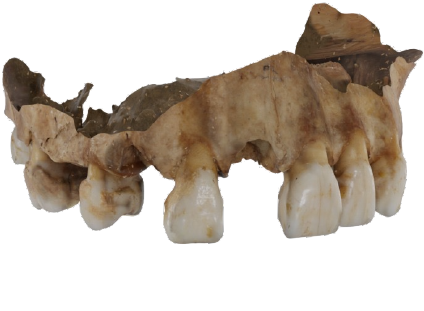
Figure 7. Textured 3D model of VII-7-2